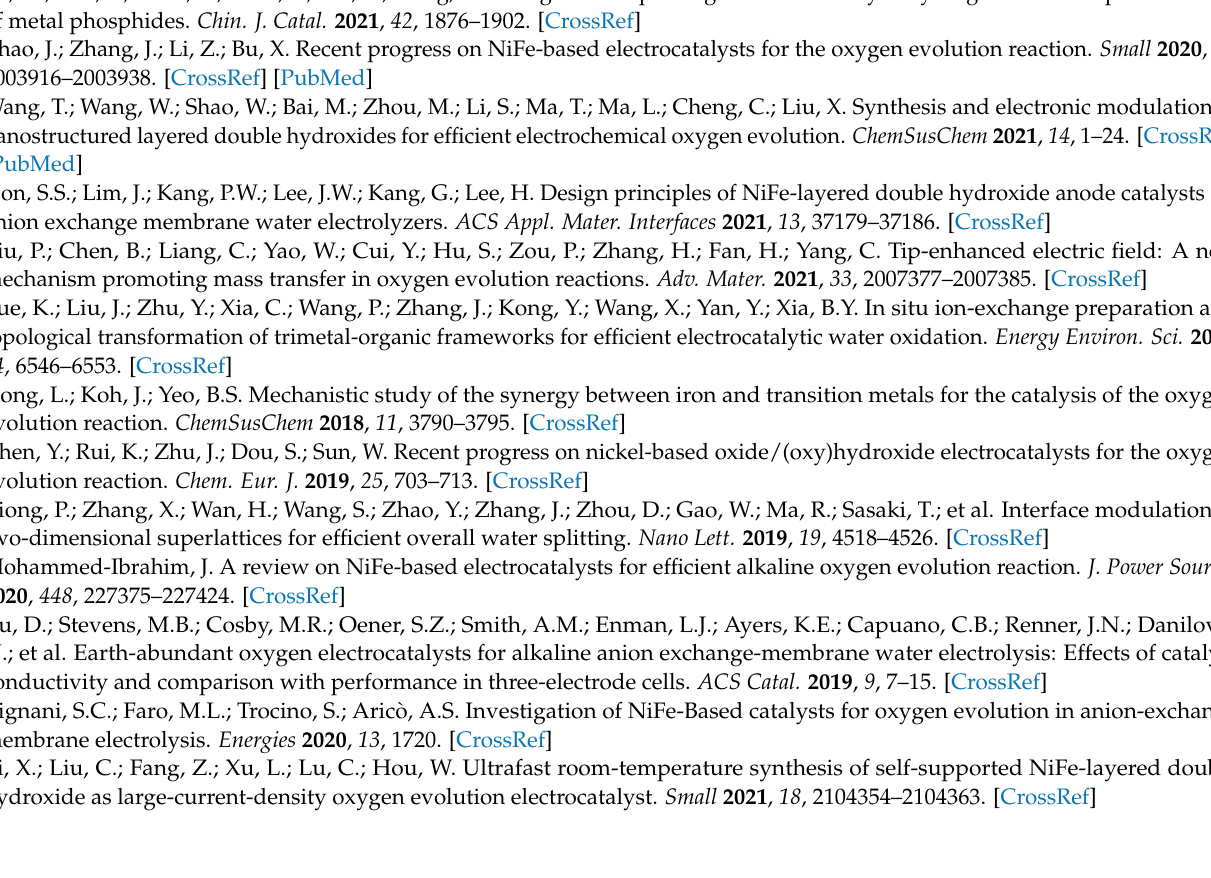
Figure S3: The SEM images of NiFe LDHs/Ni fiber after the durability test. Figure S4: The images of NiFe LDHs/Ni fiber after the durability test. XPS spectra of survey (a); Ni 2p XPS spectra (b); Fe 2p XPS spectra (c); O 1 s XPS spectra (d). Figure S5: The optical image of NiFe LDHs grown on large-scale Ni fiber. Figure S6. The digital photo of the AEMWE